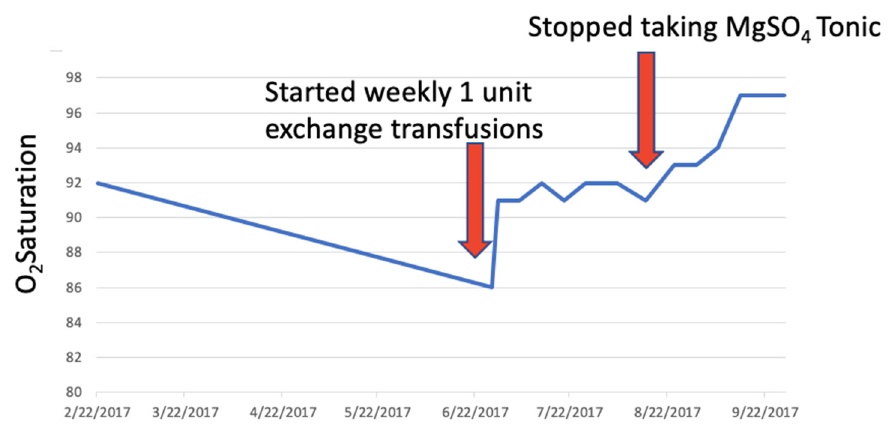
Figure 5. Plot of patient’s oxygen saturation values (blue line) from presentation and during treatment. Red arrows indicate interventions: First exchange transfusion and second cessation of ingestion of magnesium sulfate.